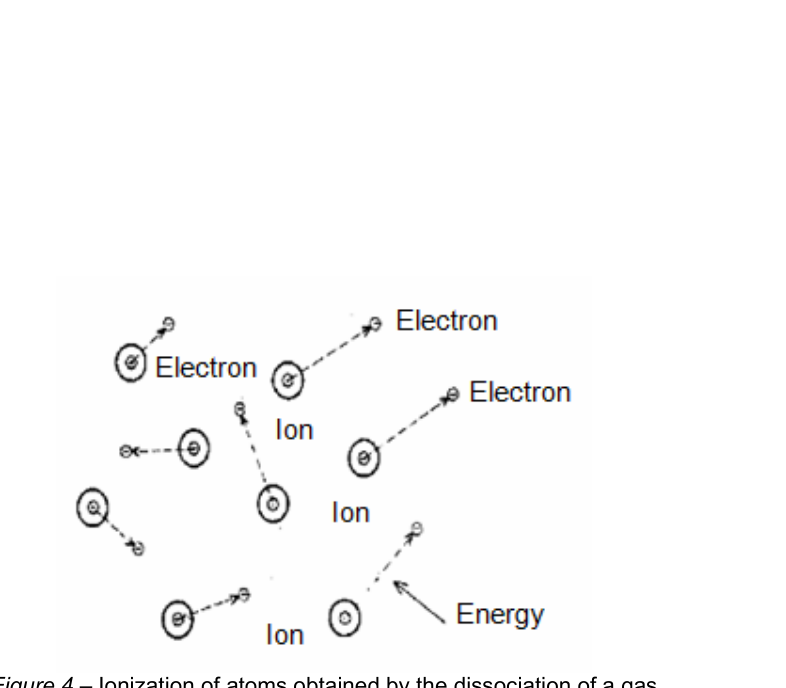
Figure 4 – Ionization of atoms obtained by the dissociation of a gas Рис . 4 – Ионизация атомов , образованная при диссоциации